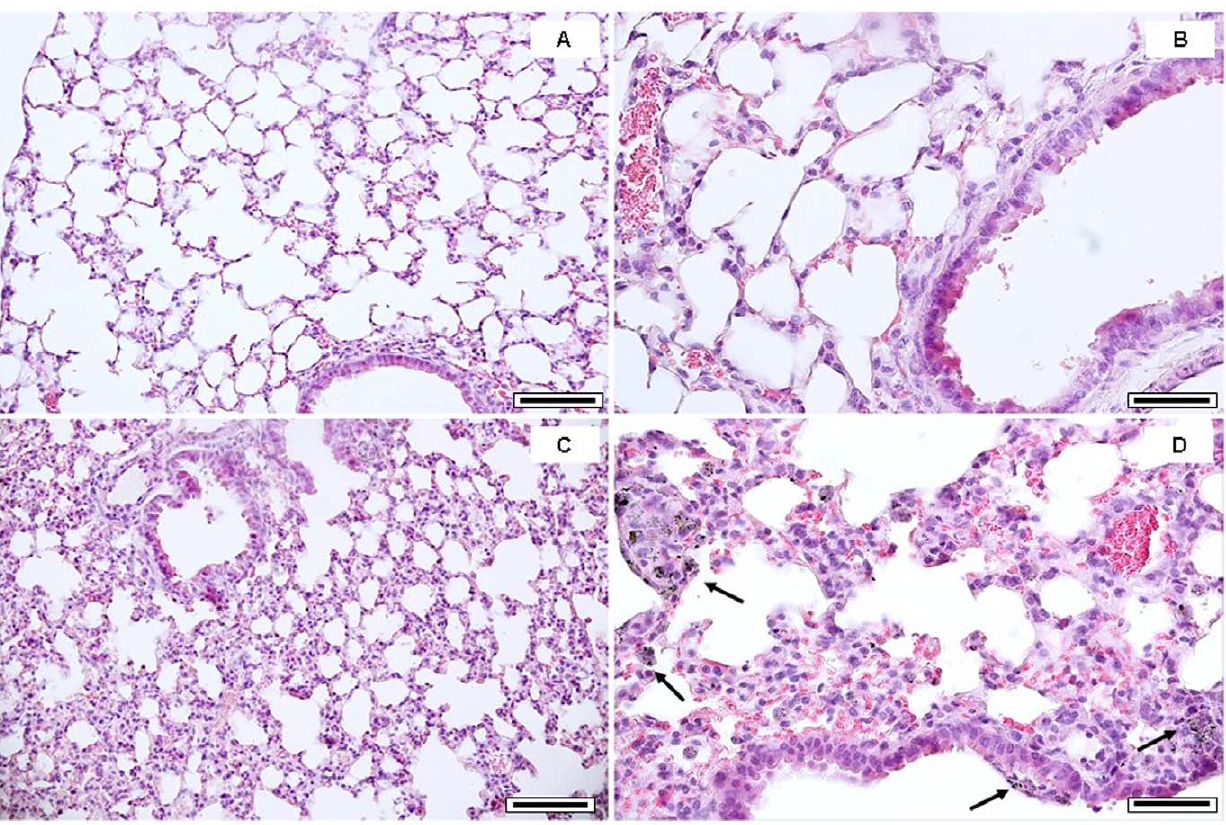
Figure 2. Lung histological analysis. Histology of lung tissue 24 h after the third intratracheal instillation. (A, B): lung parenchyma of sham mice, showing bronchiolar and alveolar epithelia; (C, D): PM10sum-treated lung parenchyma, showing inflammatory cells recruitment and AMs infiltration (arrows) in the connective surrounding terminal bronchioles and proximal alveolar sacs. Each figure represents the status evidenced examining 6 sham and 6 PM10sum-treated mice. A and C bars=150 m m; B and D bars=50 m m.